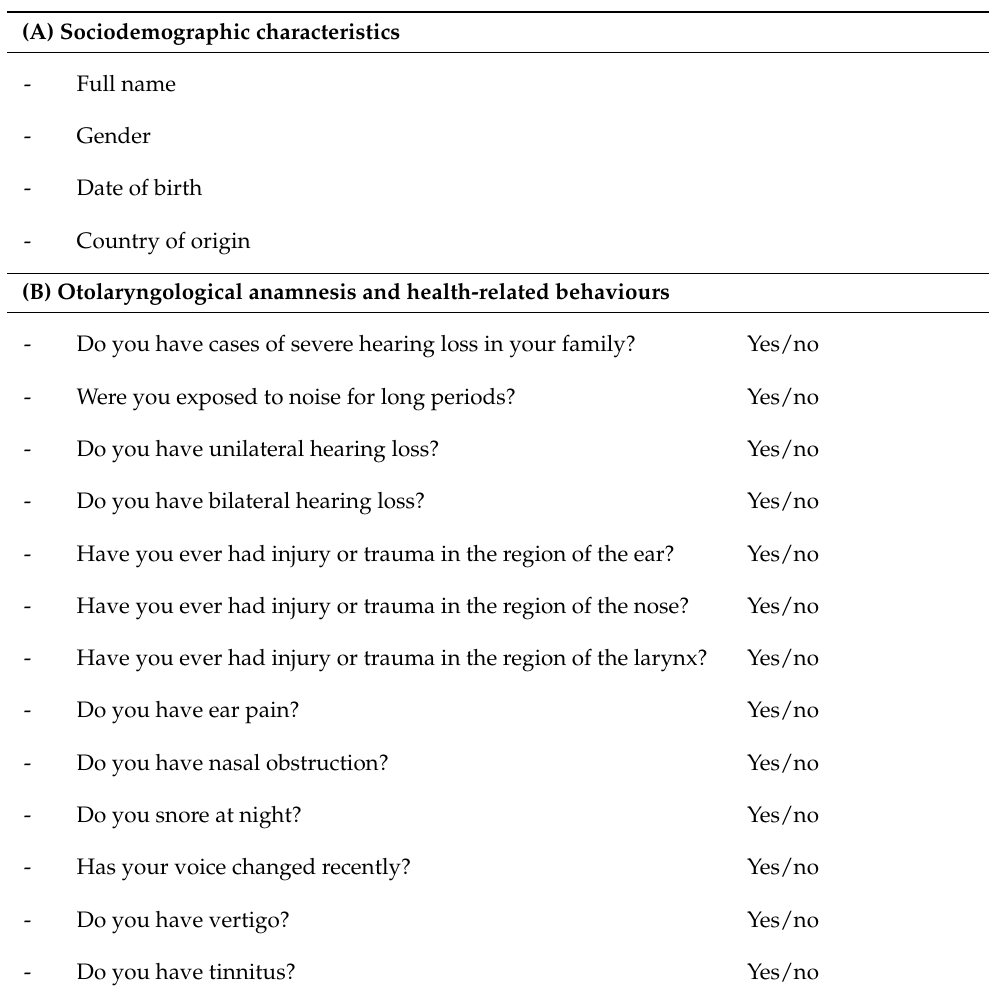
Table 1. Individually administered questionnaire to each participant through an operator- administered